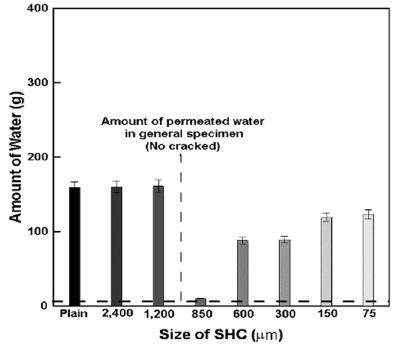
Figure 11. Test results of water permeability.